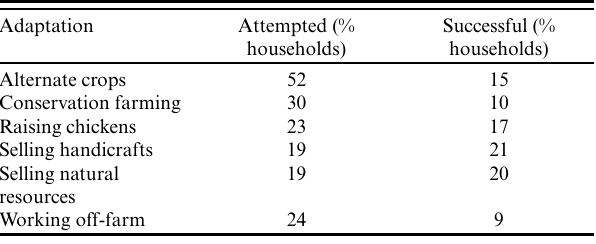
Table 1. List of adaptations, the proportion of households attempting the adaptation, and the proportion that reported that they were successful. The data summarize 240 households in the Lowveld of Eswatini that attempted to adapt.